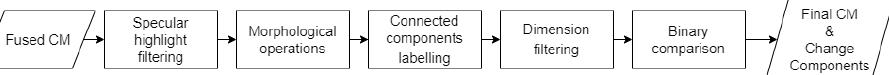
Figure 14. Change map analysis